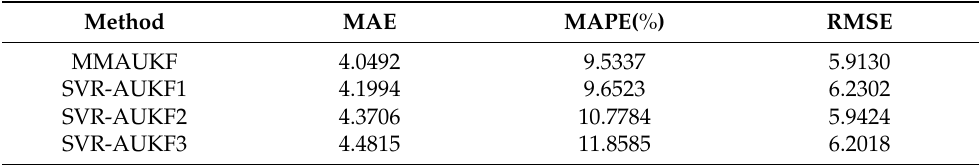
Table 2. The error performance index of three SVR-AUKF and MMAUKF